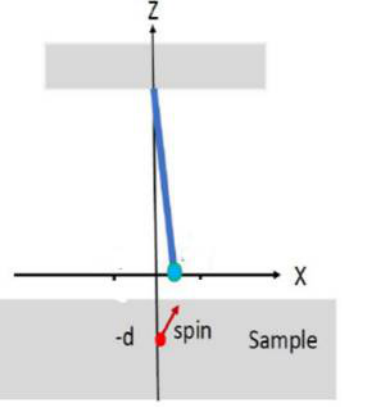
Figure 1. The oscillating cantilever with the ferromagnetic particle at its tip and a single electron spin in a sample.